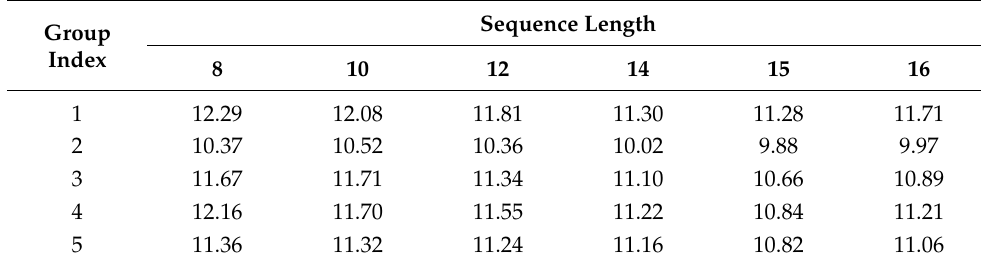
Table 7. RMSE of different input sequence lengths (units: